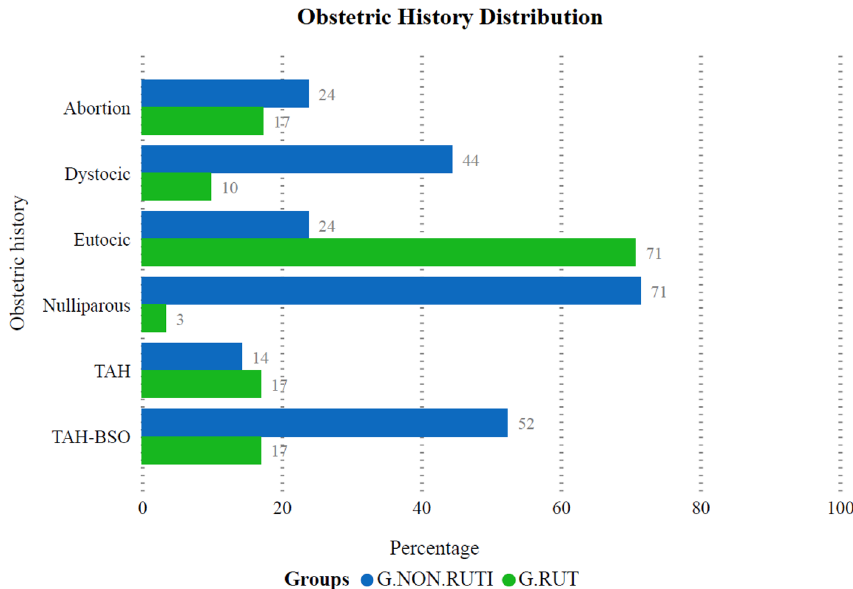
Figure 1. Percentages of distribution of obstetric history and conditions in women with urinary tract infections (G.RUTI) and without urinary tract infections (G.NON.RUTI). TAH Total abdominal hysterectomy without adnexectomy, TAH-BSO Hysterectomy with adnexectomy (total abdominal hysterectomy and bilateral salpingo-